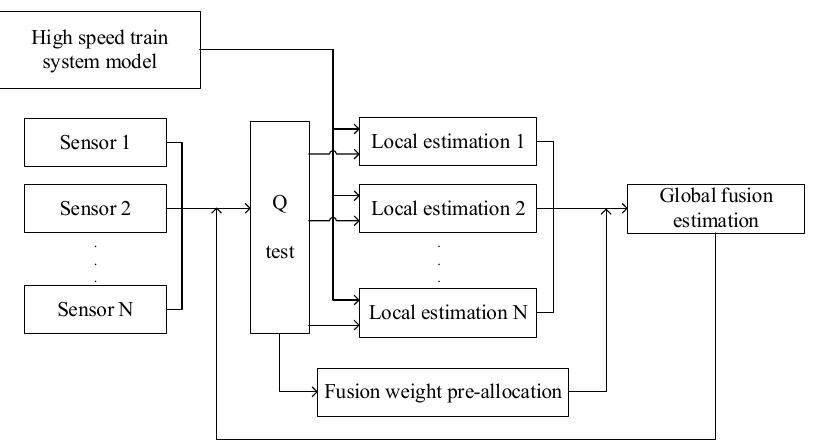
Figure 4. Doppler radar speed sensor and installation example: ( a ) doppler radar speed sensor; ( b )